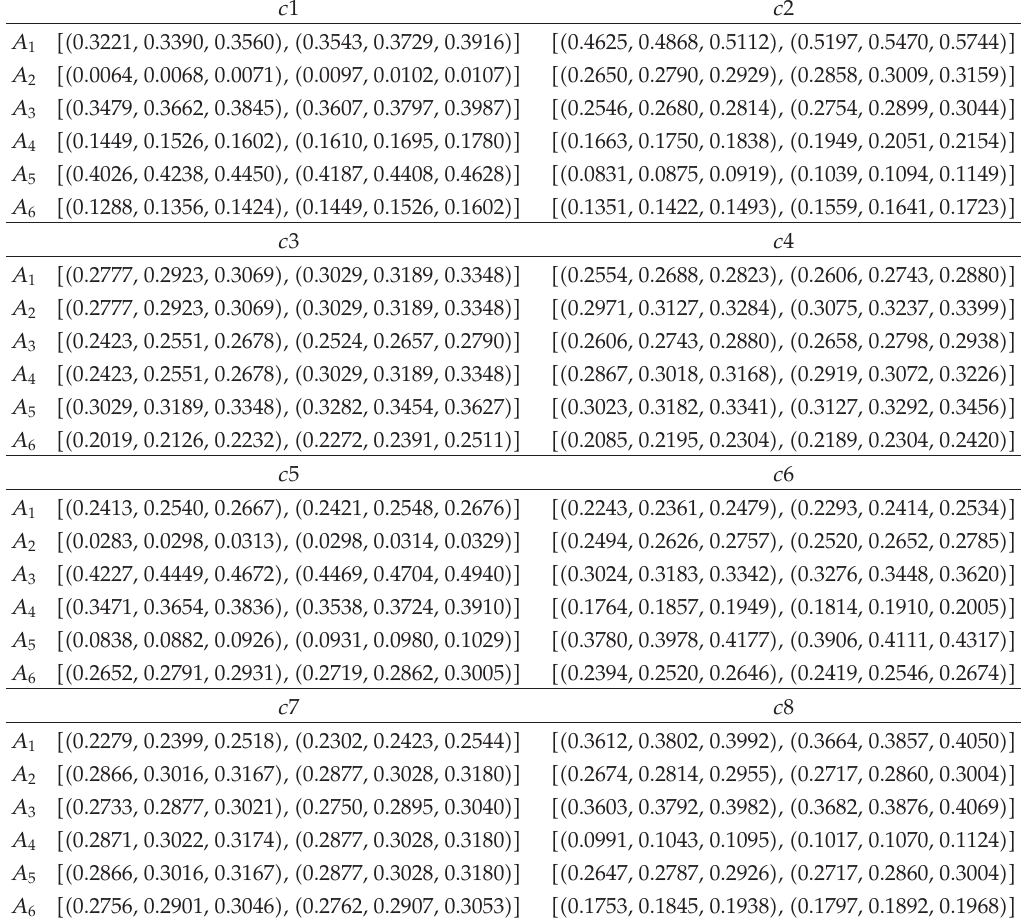
Table 3: A fuzzy normalized decision matrix. c 1 c